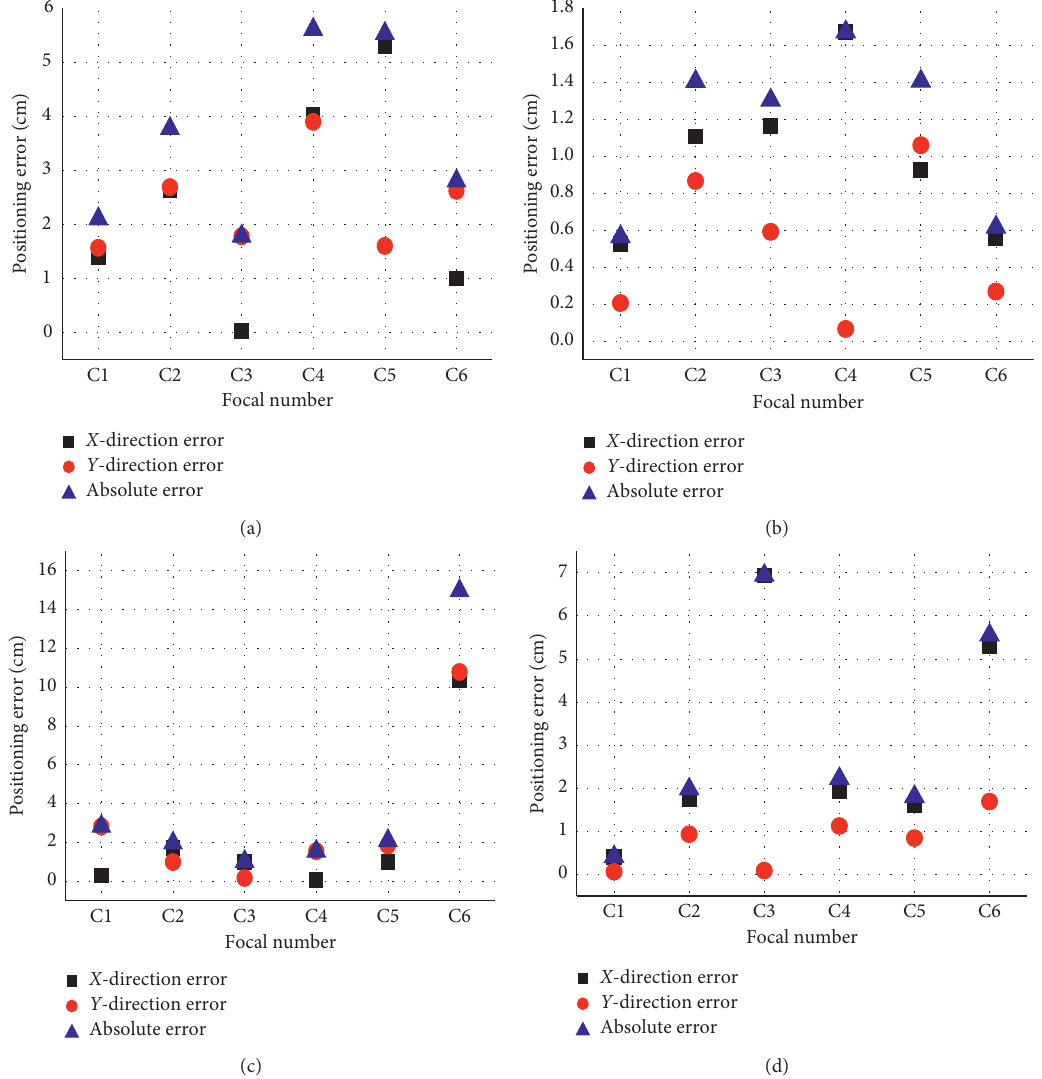
Figure 10: The analysis of the location errors of plate-shaped rock. (a) GAM-L in Scheme I, (b) GAM-L in Scheme II, (c) G3761-L in Scheme I, and (d) G3761-L in Scheme